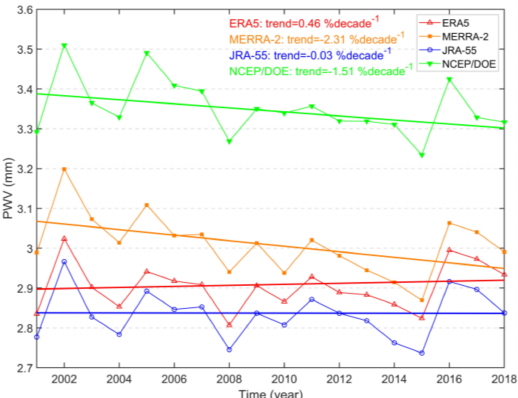
Figure 12. PWV time series averaged from ERA5, MERRA-2, JRA-55 and NCEP/DOE over Antarctica during the period